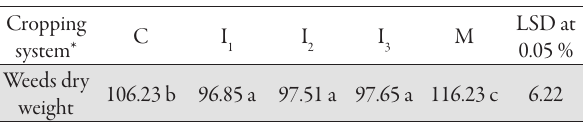
Tab. 3. Effect of different cropping system on dry weight of weed (kg ha -1